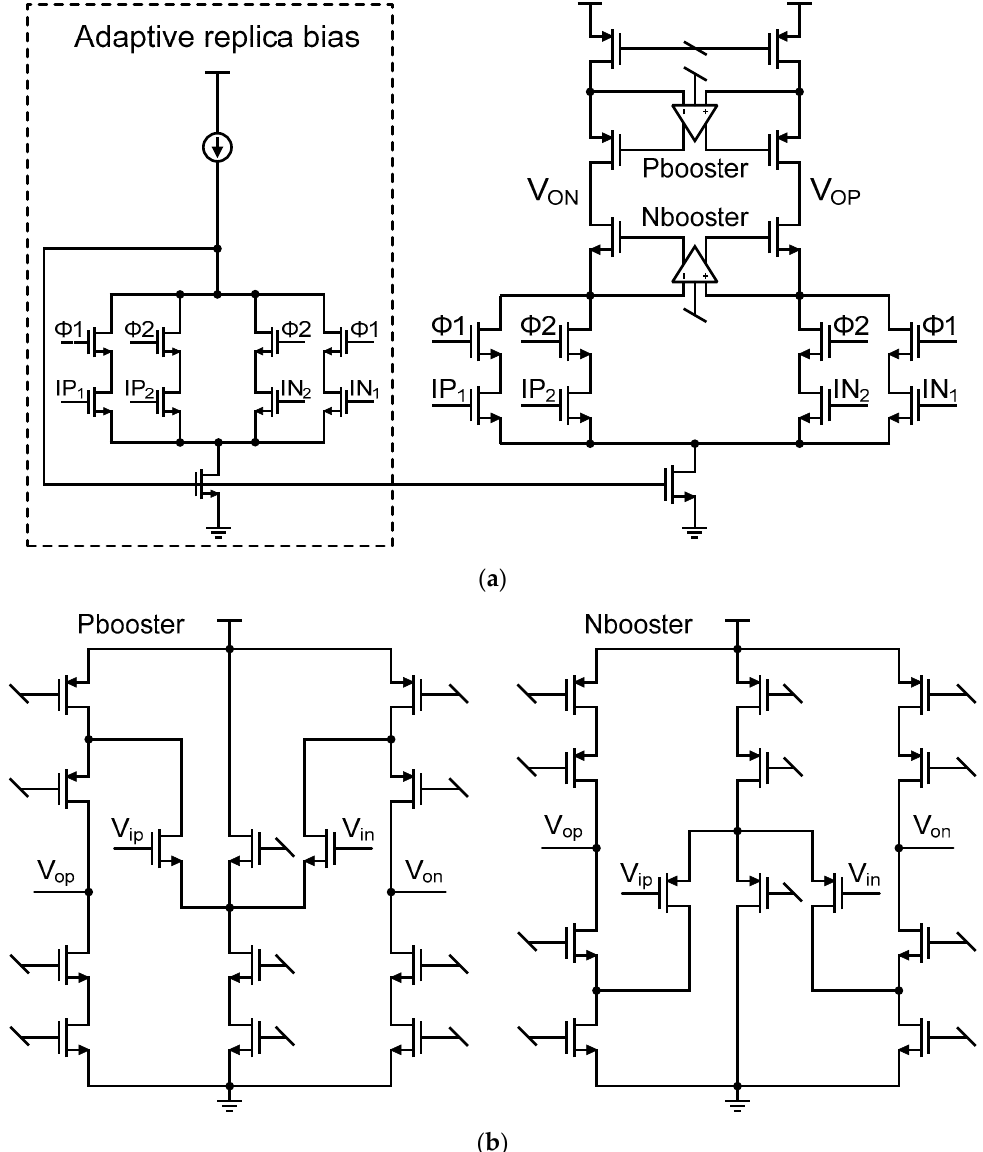
Figure 4. ( a ) Dual-input single-stage telescopic opamp with adaptive biasing; ( b ) Booster